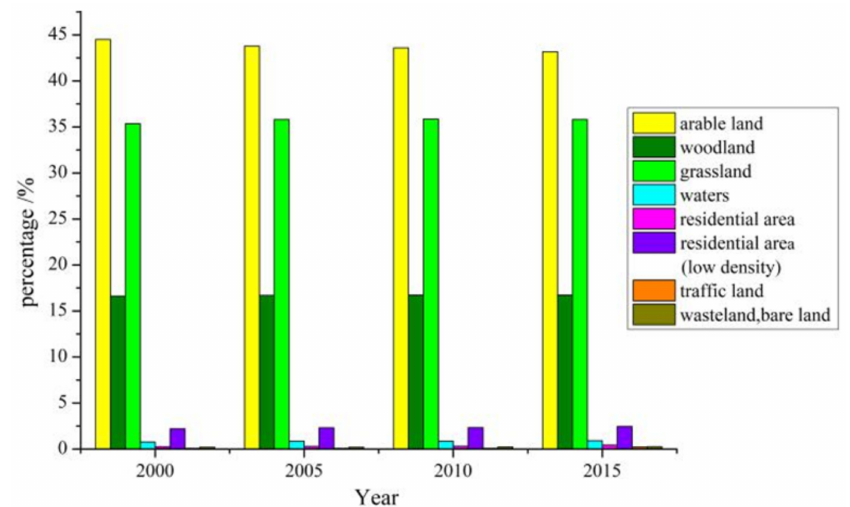
Figure 9. Proportions of land use types in different